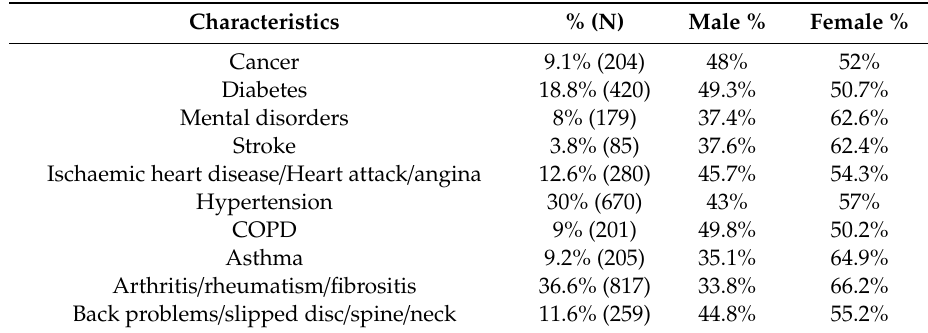
Table 1. Morbidities profile of older adults with multimorbidity.